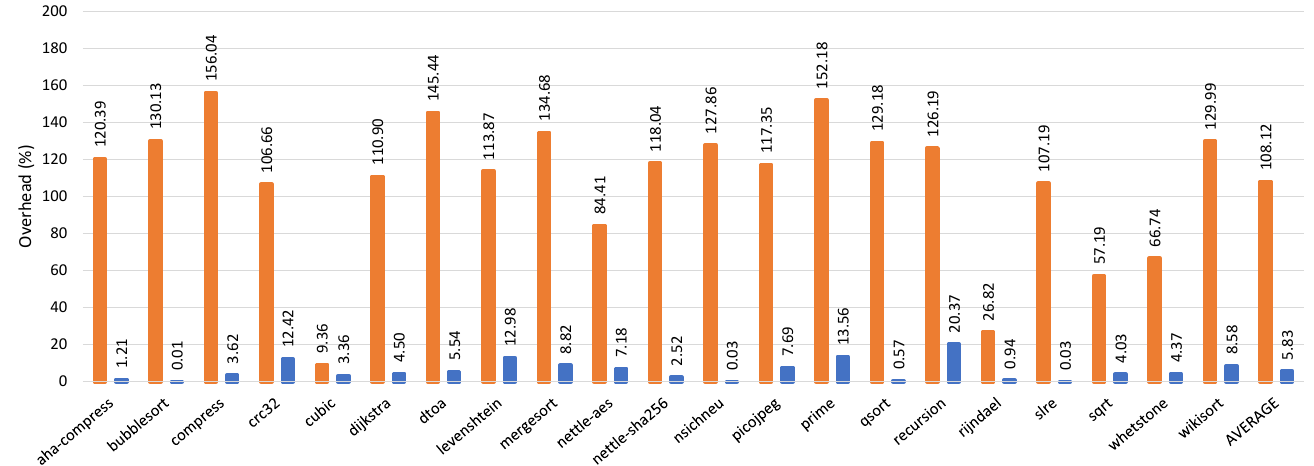
Figure 8. Execution time overhead for the shadow stack with CoMeT and TME.